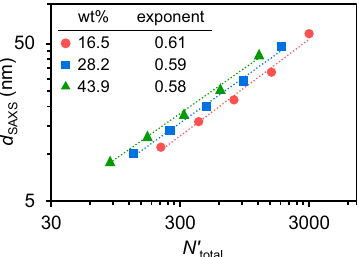
Fig. 5 Power law scaling for domain spacings of 3D printed PIMS materials. Log-log plot of domain spacing ( d SAXS ) as a function of total degree of polymerization ( N' total ). d SAXS determined from SAXS. N' total was calculated based on a common monomer reference volume (118 Å 3 ). Power law regression lines and scaling exponents (inset table) are